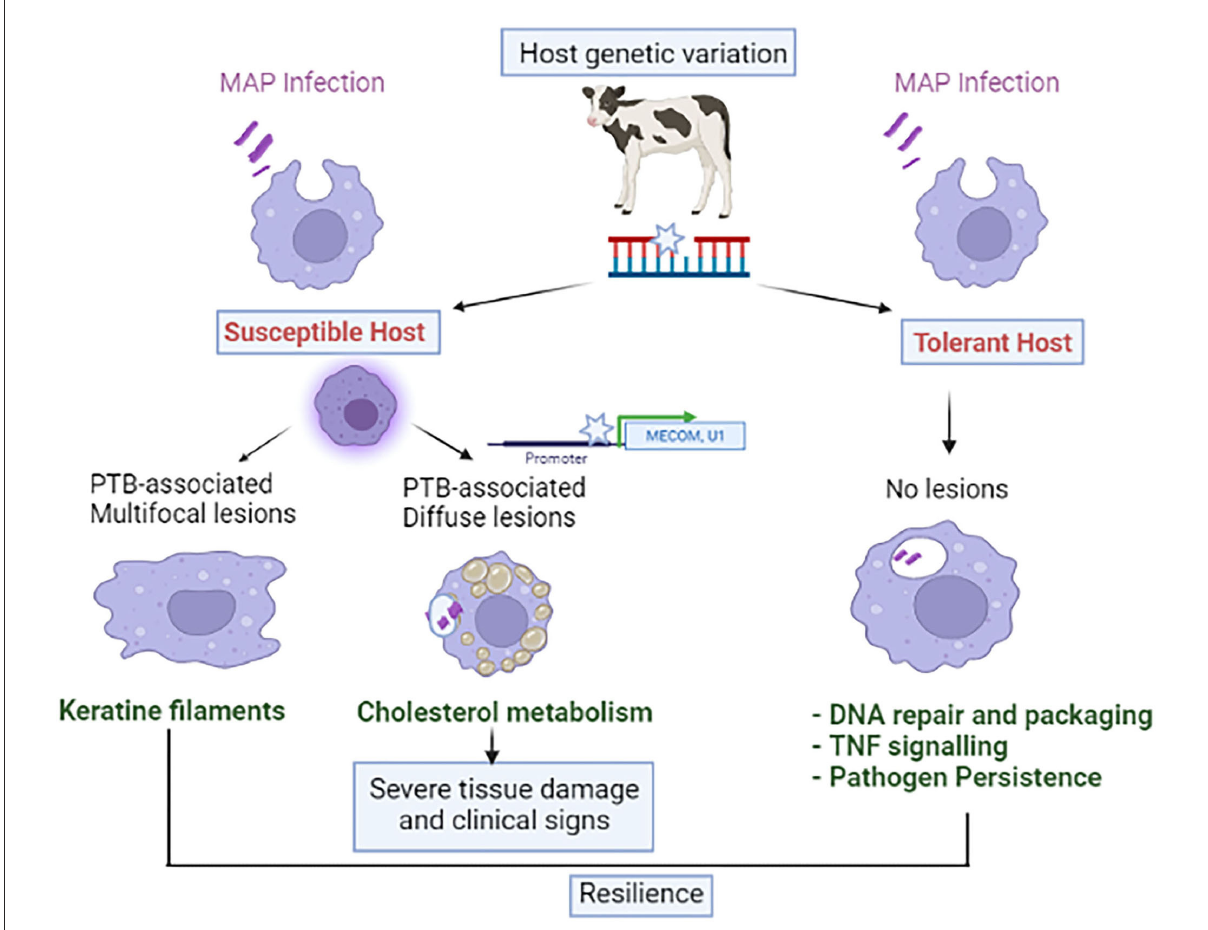
FIGURE2 Interaction between host genetics and MAP infection with disease phenotype.